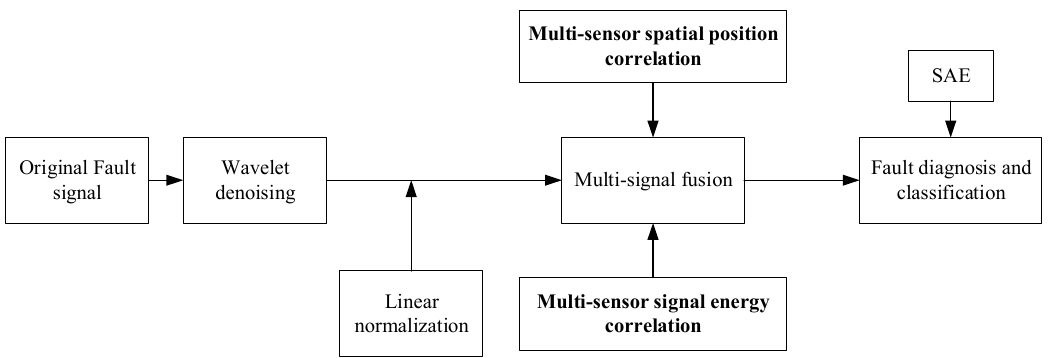
Figure 1. The overall framework and ideas of the content.